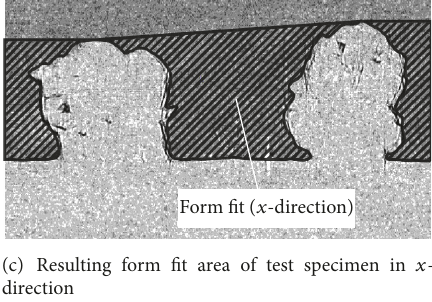
Figure 9: CT image of PA66—HDPE test specimen, produced by prestructuring and subsequent vibration